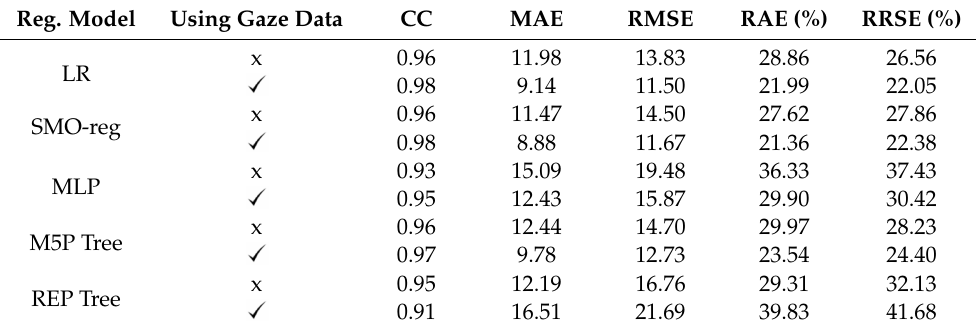
Table 4. The results of using different regression techniques with and without eye-tracking data. Reg.